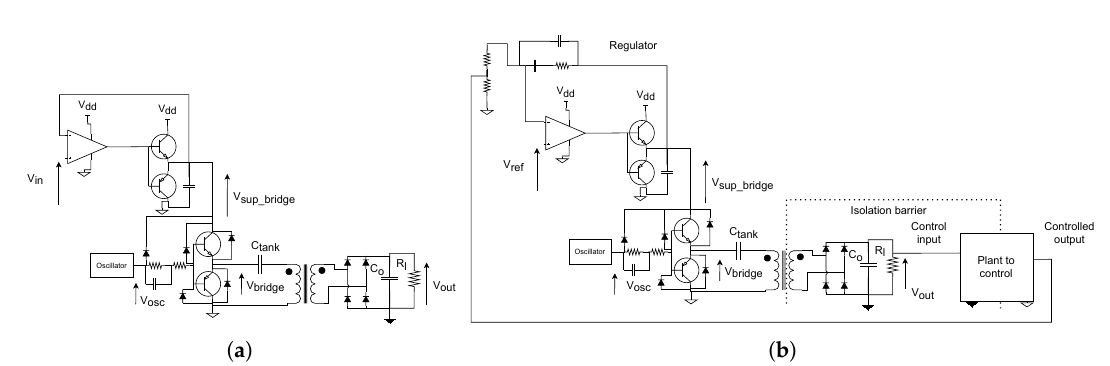
Figure 4. Analog Isolator options: ( a ) Implementation with op-amp; ( b ) Integration with control loop.